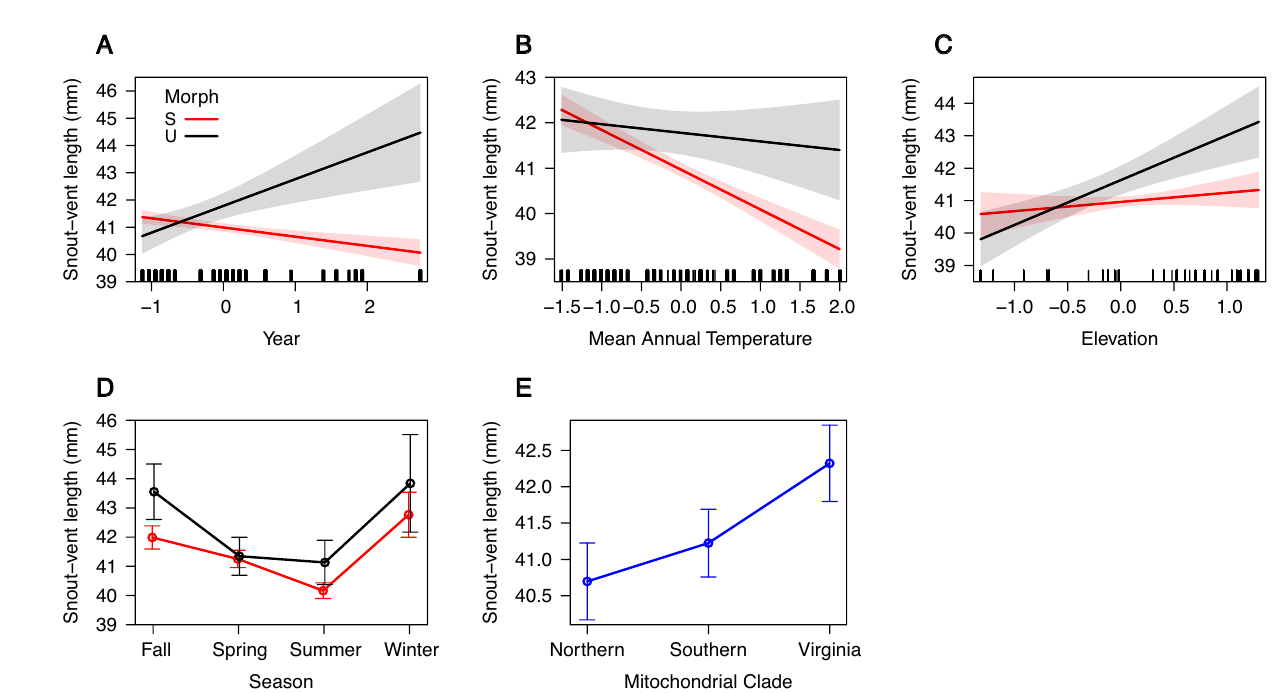
Figure 3. Top model effect plots of significant predictors of color morph frequency in Plethodon cinereus . The proportion of color morphs is influenced by ( A ) year, ( B ) mean annual temperature, ( C ) elevation, ( D ) mean annual precipitation, and ( E ) season. Error bars in each plot represent 95% confidence intervals.